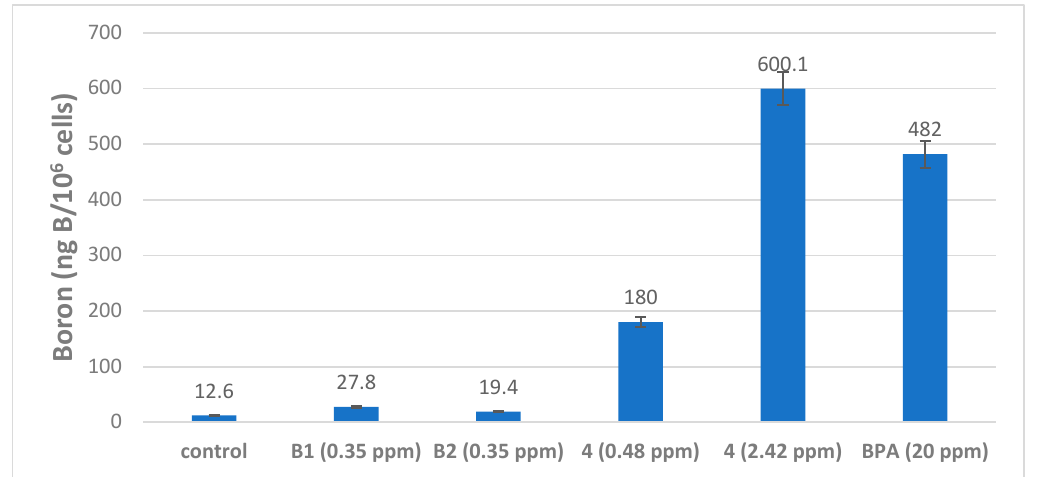
15 of 24 Figure 9. Survival fraction in SCC VII cells. BPA: 20 ppm 10 B; compound 4 : 0.48 ppm 10 B treated with SCC VII cells for 4 h. 2.5. Boron Cell Concentration Determination The boron concentrations of MMP carboranes 1 ( B1 ), 2 ( B2 ), 4, and BPA in SCC VII and in U87 delta EGFR cells are shown in Figures 10 and 11, respectively. The boron con- centration of BPA (20 ppm 10 B) and MMP carborane 4 (0.48 ppm 10 B) in SCCVII cells were 482 ng/E6 cells and 180 (consists of 22% 10 B, therefore 39.6 10 B) ng/E6 cells (Figure 10). Additionally, the 1 ( B1 ) and 2 ( B2 ) concentrations were very low: 27.8 ng and 19.4 ng, respectively, while the boron concentration of BPA (20 ppm 10 B) and MMP carborane 4